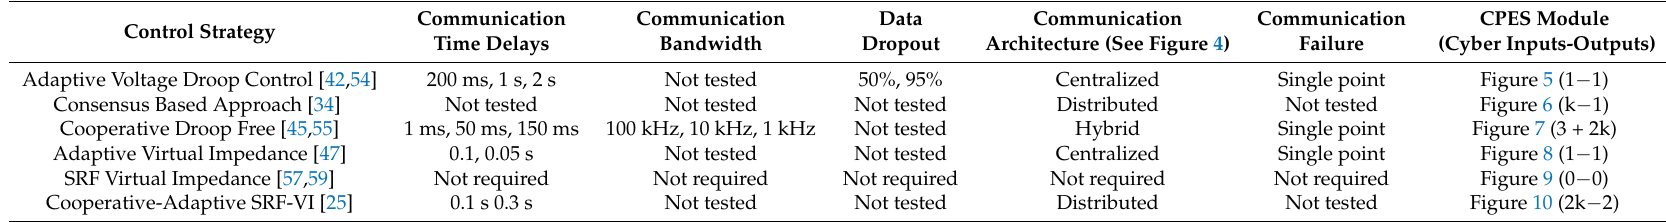
Table 1. Cybernetic requirements analysis.